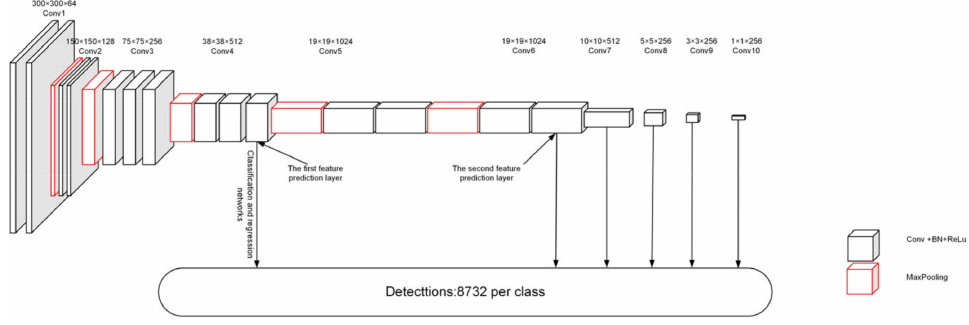
Figure 2. SSD approach backbone